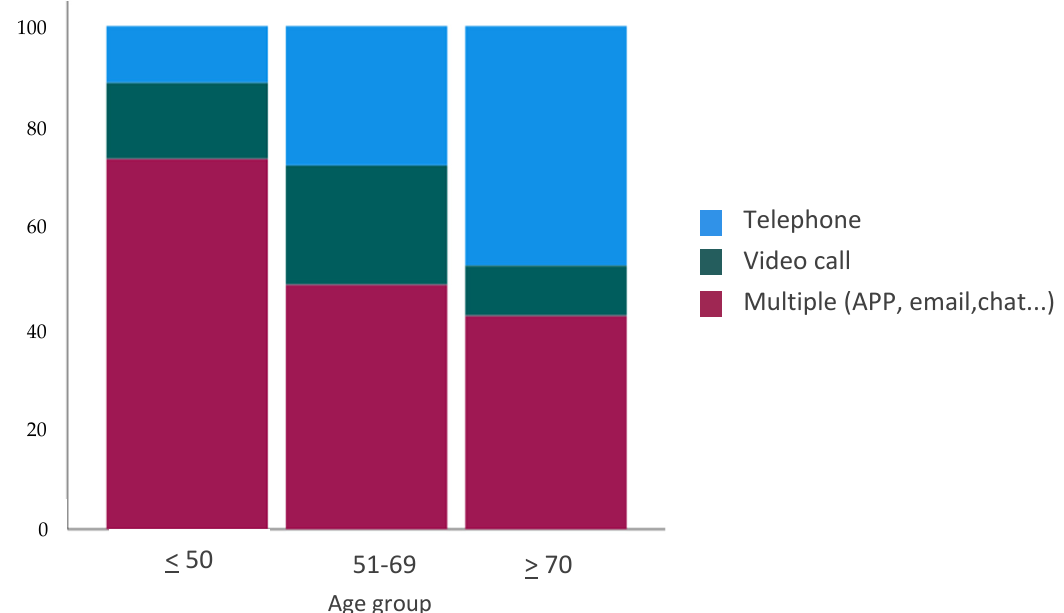
Figure 6. Knowledge of technology. Q11: What is your knowledge of new technologies?